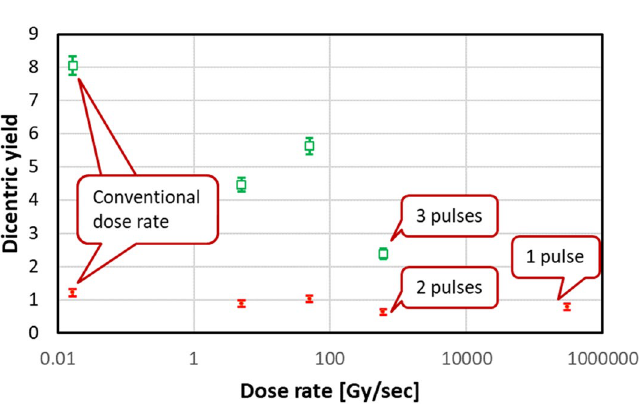
Figure 11. Dicentric yields for 3 Gy (red closed symbols) and 8 Gy(green open symbols) irradiations at different dose rates. No dicentrics or multicentrics (yield = 0 ± 0) seen in control